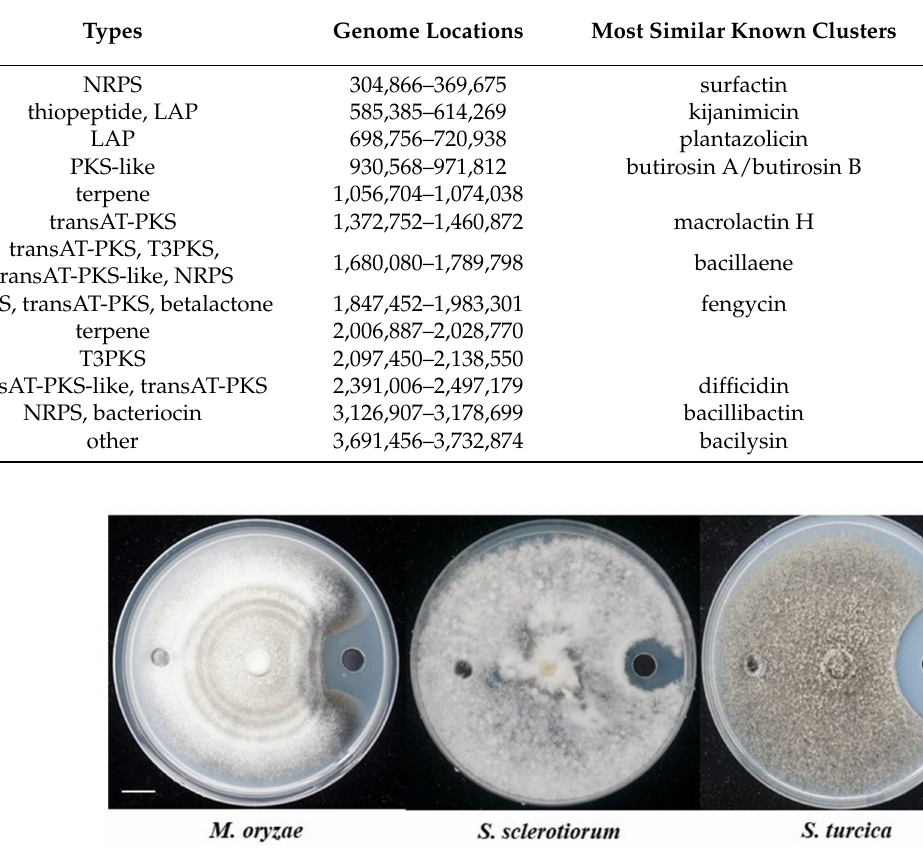
Figure 6. Antagonistic activity of crude lipopeptide extract from B. velezensis GS-1 against indicated plant pathogenic fungi. Scale bar: 1 cm.